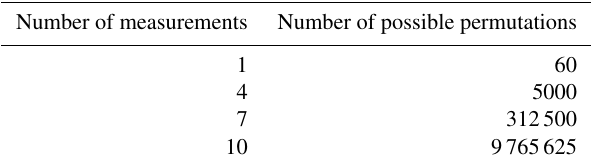
Table A1. Number of possible permutations of successive virtual crossings used for